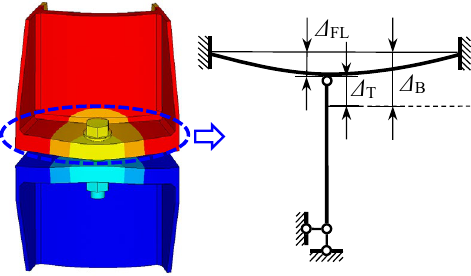
Figure 10. Relationship between